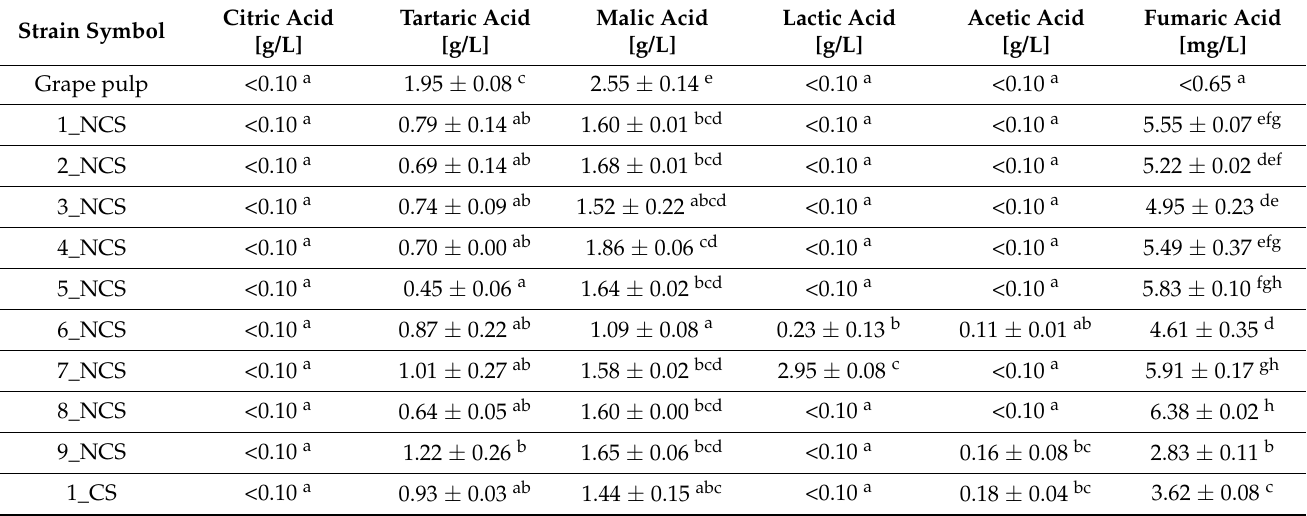
Table 6. Analysis of selected organic acids in red